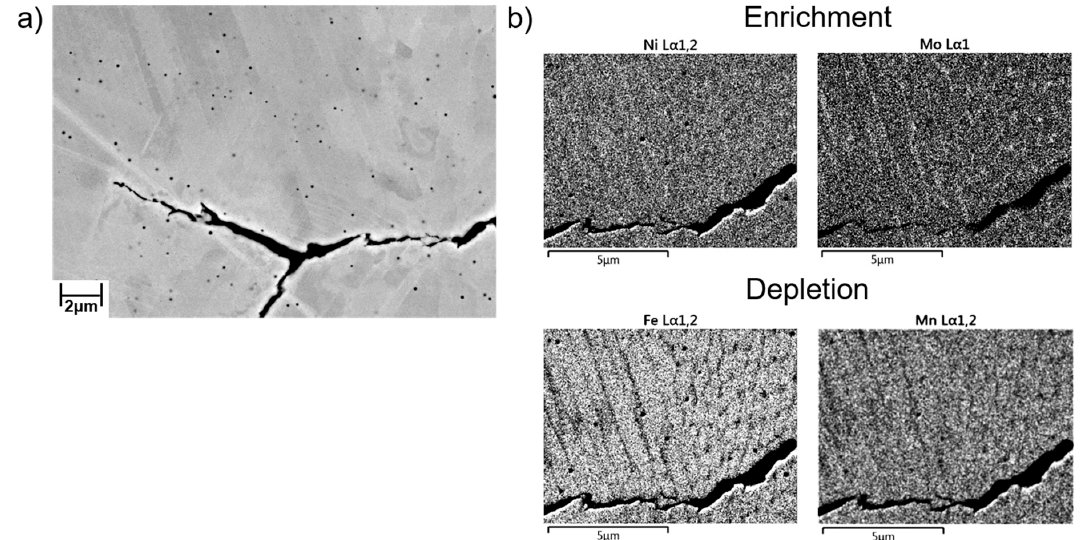
Figure 17. ( a ) Traces of elemental segregation and ( b ) corresponding EDX mappings.